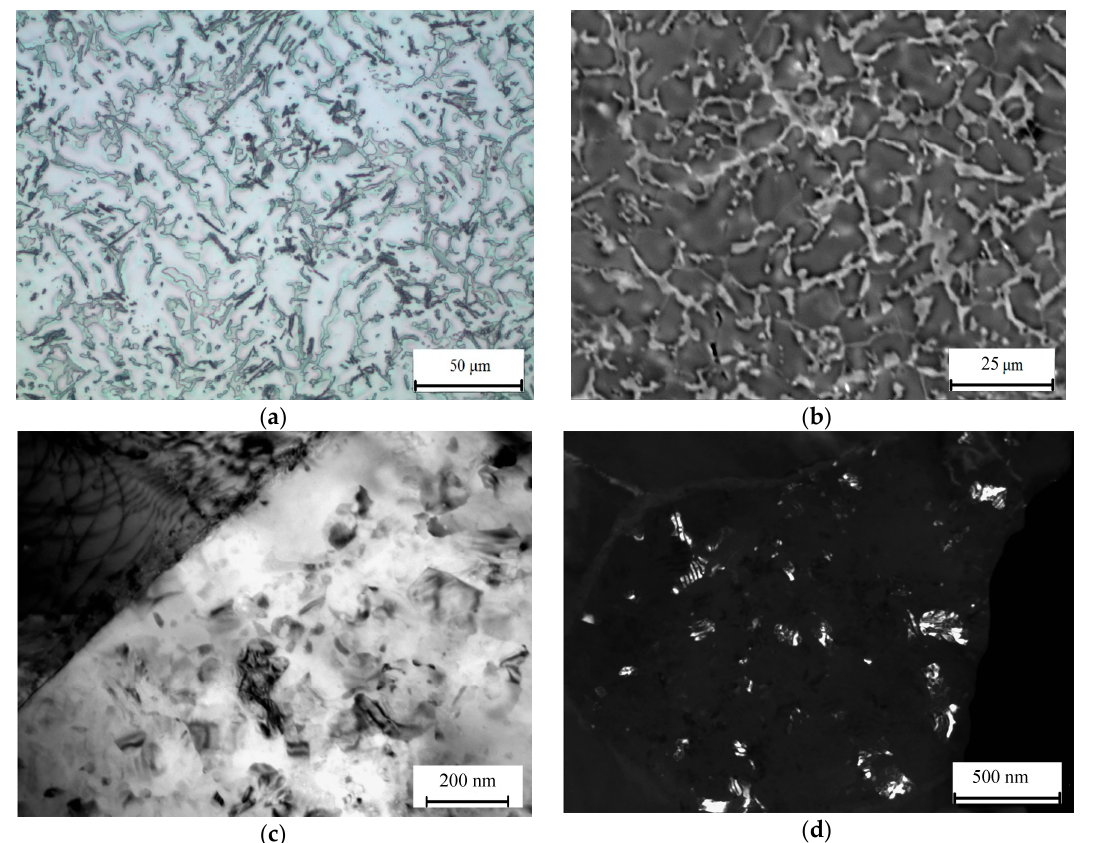
Figure 8. Microstructure of alloy Al10Mg3Ca1Si. ( a ) OM, ( b ) SEM, ( c , d ) transmission electron microscope (TEM): ( a ) as-cast; ( b – d ) solution treatment at 440 ◦ C, 3 h; water quenching and aging at 200 ◦ C, 3 h, ( c ) bright field, ( d ) dark field (Al 3 Mg 2 ).